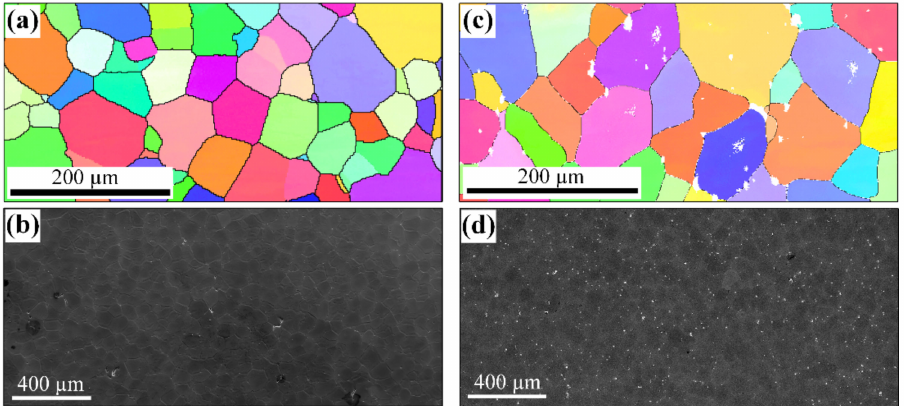
Figure 2. Microstructures of the as-cast Al-8Zn ( a , b ) and Al-6Bi-8Zn ( c , d ) alloys. ( a , c ) EBSD-IPF maps, ( b , d ) SEM-BSE